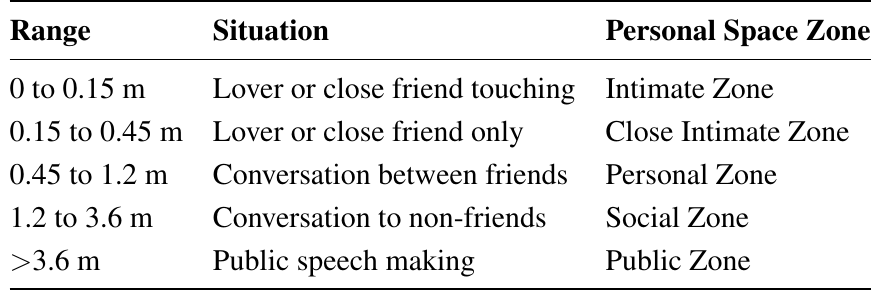
Table 1. Human-Human Personal Space